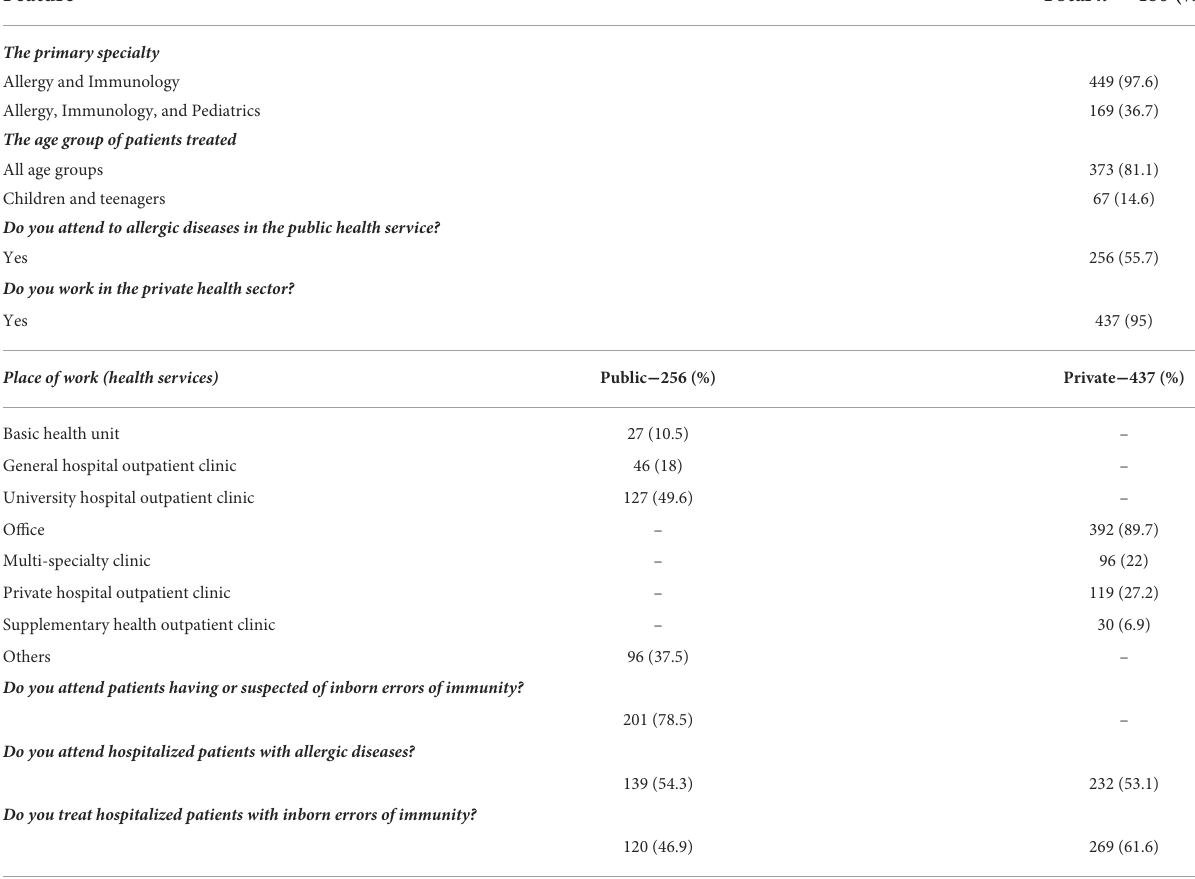
TABLE 1 The primary specialty, age group of the patients, and workplace of Brazilian